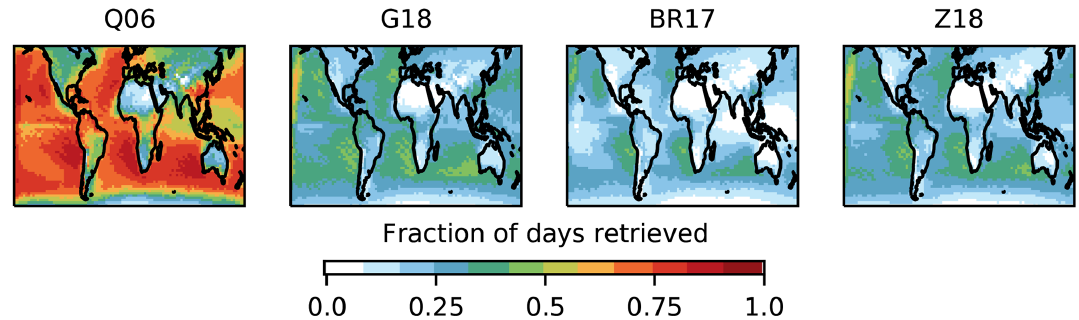
Figure 8. The fraction of 1 ◦ × 1 ◦ daily pixels with an N d retrieval for each sampling